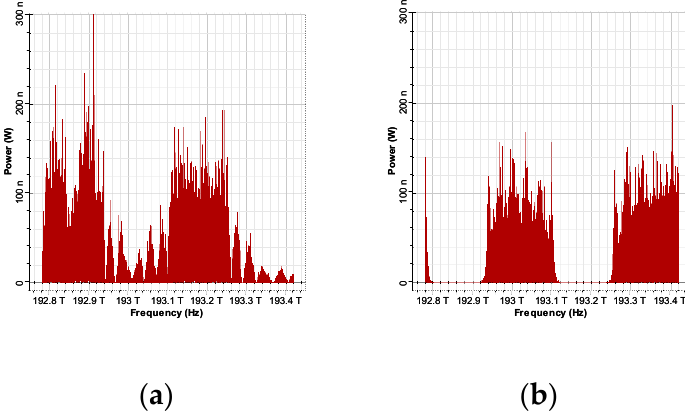
Figure 5. The coded packet signals in the wavelength domain ( a ) Hadamard code (1,0,1,0); and ( b ) complementary Hadamard code (0,1,0,1).